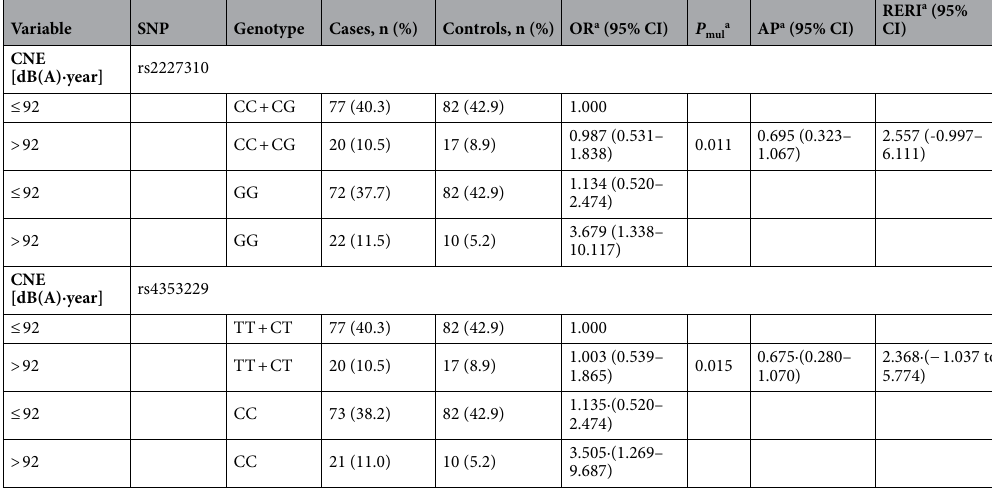
Variable SNP Genotype Cases, n (%) Controls, n (%) OR a (95%